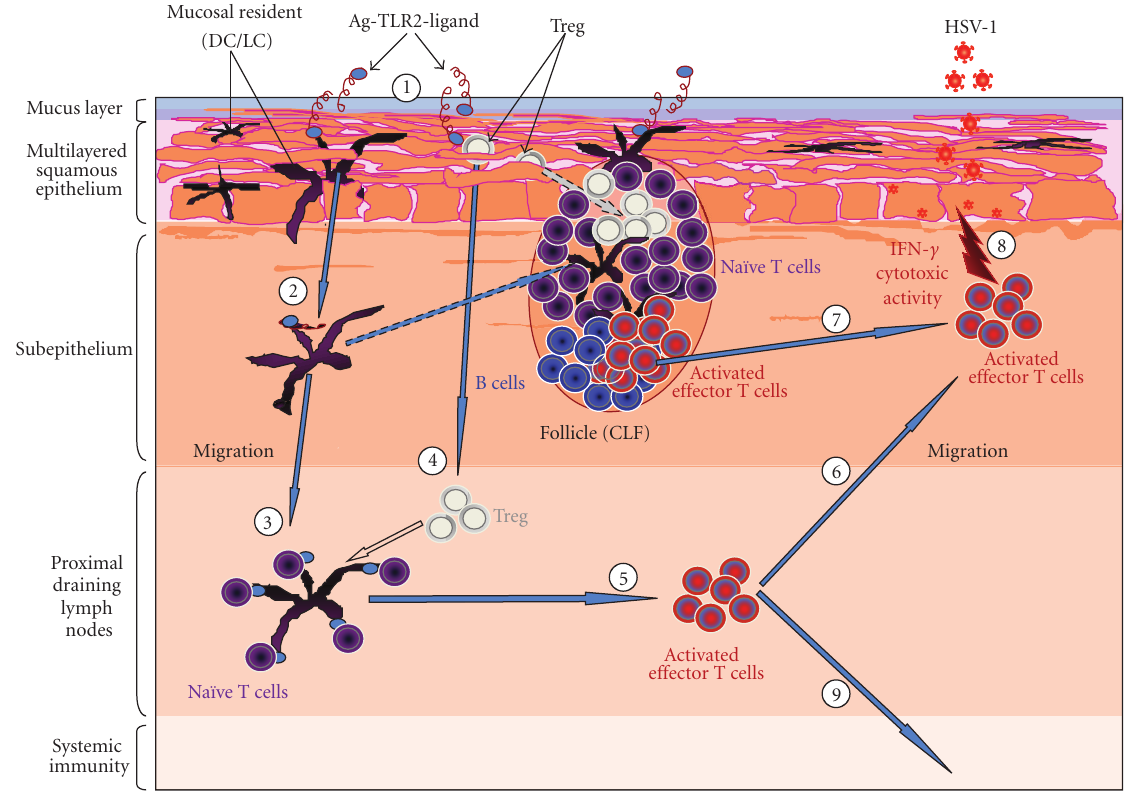
Figure 1: Model of immune mechanisms of TLR2-mediated control of an anti-HSV-1 immune response in the conjunctiva. During topical ocular immunization with TLR2 agonist (1), high concentration of exogenous TLR2 agonist is sensed by conjunctiva APC and Treg cells residing in the epithelium and then triggers the migration of conjunctiva resident APC (DC) and Treg to the proximal draining lymph node (2, 4) or (dashed arrow) to the conjunctiva lymphoid follicles (CLF). TLR2/TLR2L interaction promotes maturation of DC and proliferation of Tregs paralleled by temporarily abrogated suppression (empty arrow). As a result, Tregs do not suppress the ongoing immune response in the draining lymph node or in CLF. (3) DC stimulate na¨ıve CD4+ and CD8+ e ff ector T cells which undergo cell division and proliferation in the draining LN (5) or CLF where they form with B cells a germinal center (characteristic of lymphoid follicles). Activated e ff ector T cells migrate to the epithelium and kill HSV-1-infected epithelial cells through CTL activity. Some activated e ff ector cells in the LN preferentially migrate to the periphery through lymphoid a ff erent canal to induce systemic immune response. Once HSV-1 is cleared by the immune system and the source of TLR2 ligands is no longer present, Tregs will regain their suppressive capabilities, thus contributing to the balance between tolerance and